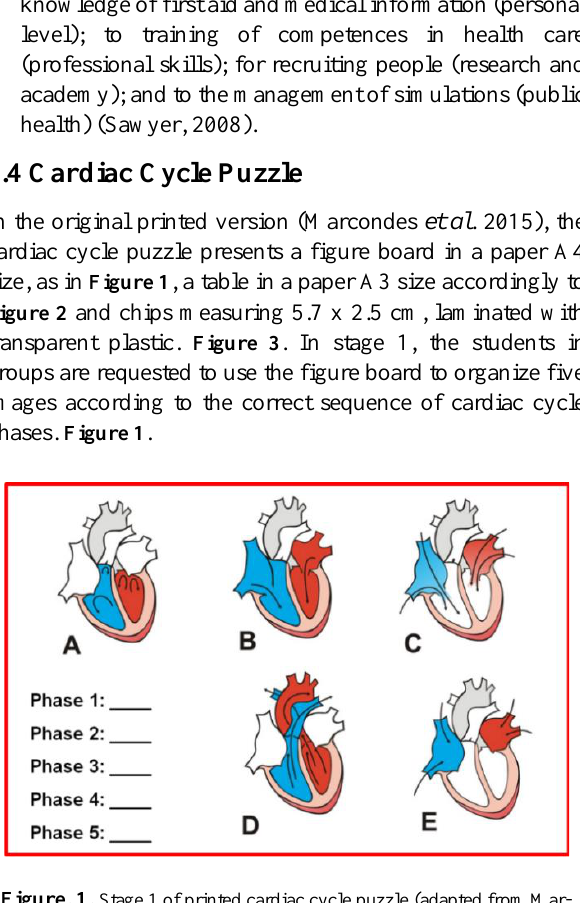
Figure. 1. Stage 1 of printed cardiac cycle puzzle (adapted from Mar- condes et al. 2015).